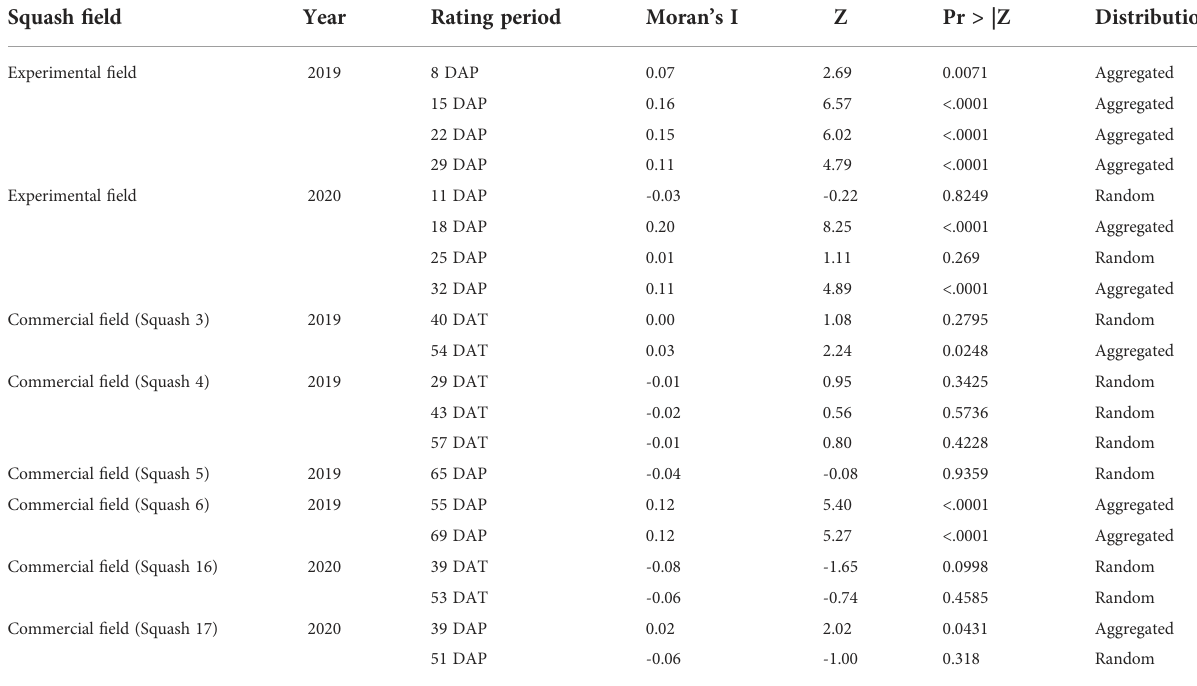
TABLE 5 Two-dimensional spatial distribution of adult white fl ies based on number of adults caught on traps in yellow squash fi elds based on spatial autocorrelation analysis per fi eld and per rating period. Squash fi eld Year Rating period